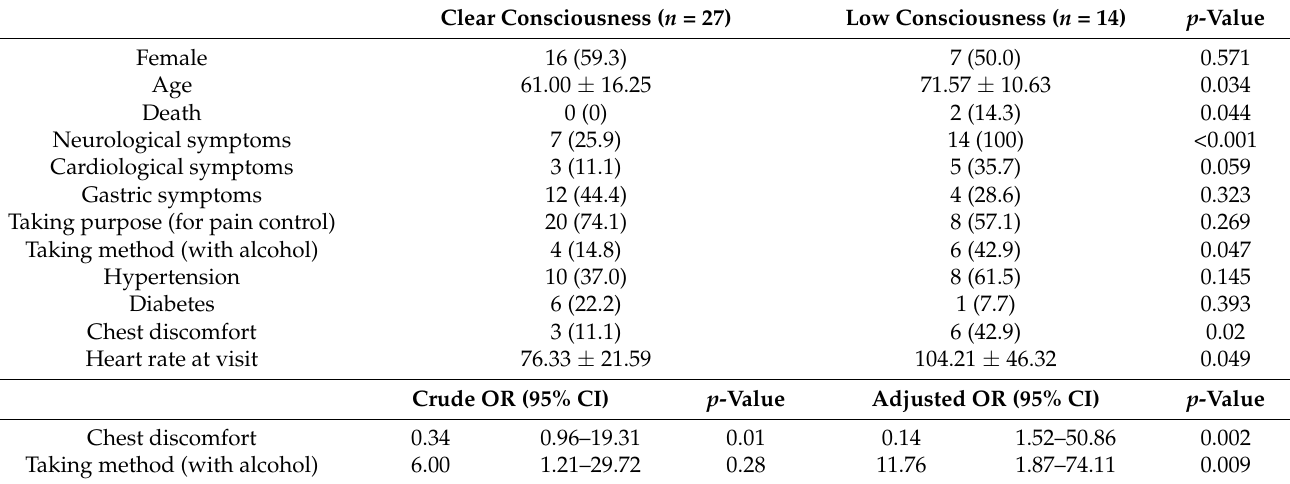
Table 3. Factors associated with consciousness